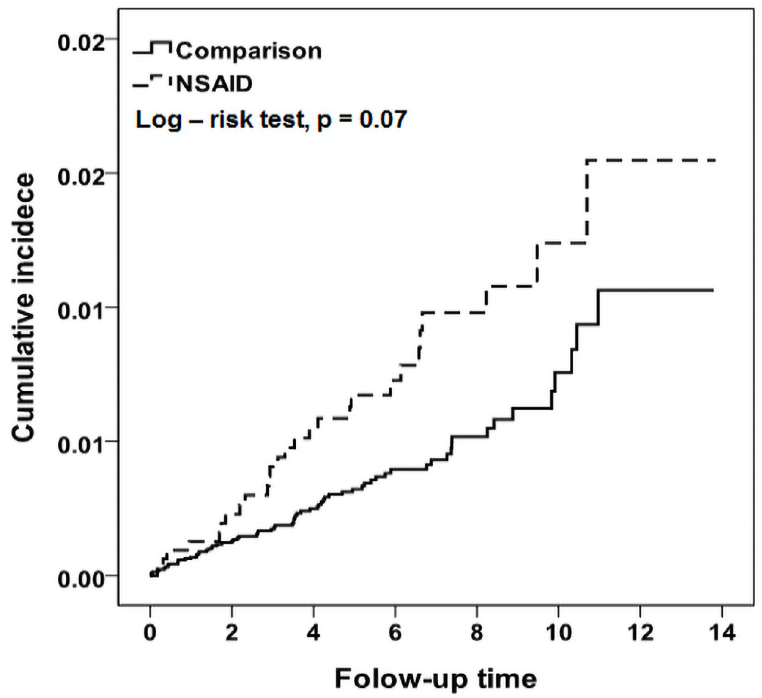
Fig 2. Log-risk test for evaluating the comparative cumulative incidence of stroke among NSAID users and non- NSAID users.